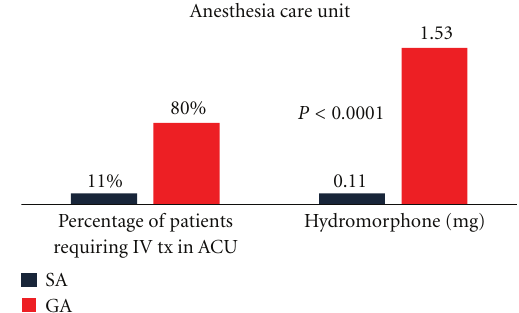
Figure 1: Percentage of patients requiring IV Hydromorphone and the dosage amount received by patients in the recovery room: spinal anesthesia in black versus general anesthesia in red.